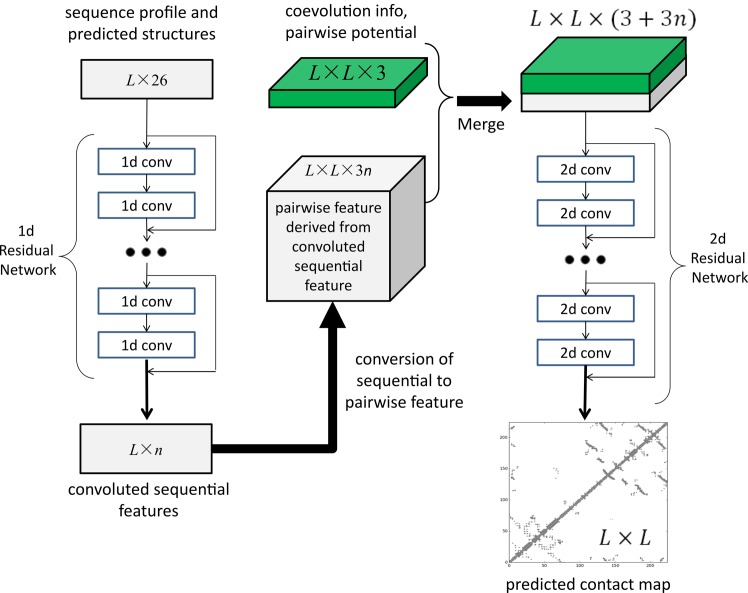
Illustration of our deep learning model for contact prediction where L is the sequence length of one protein under prediction.